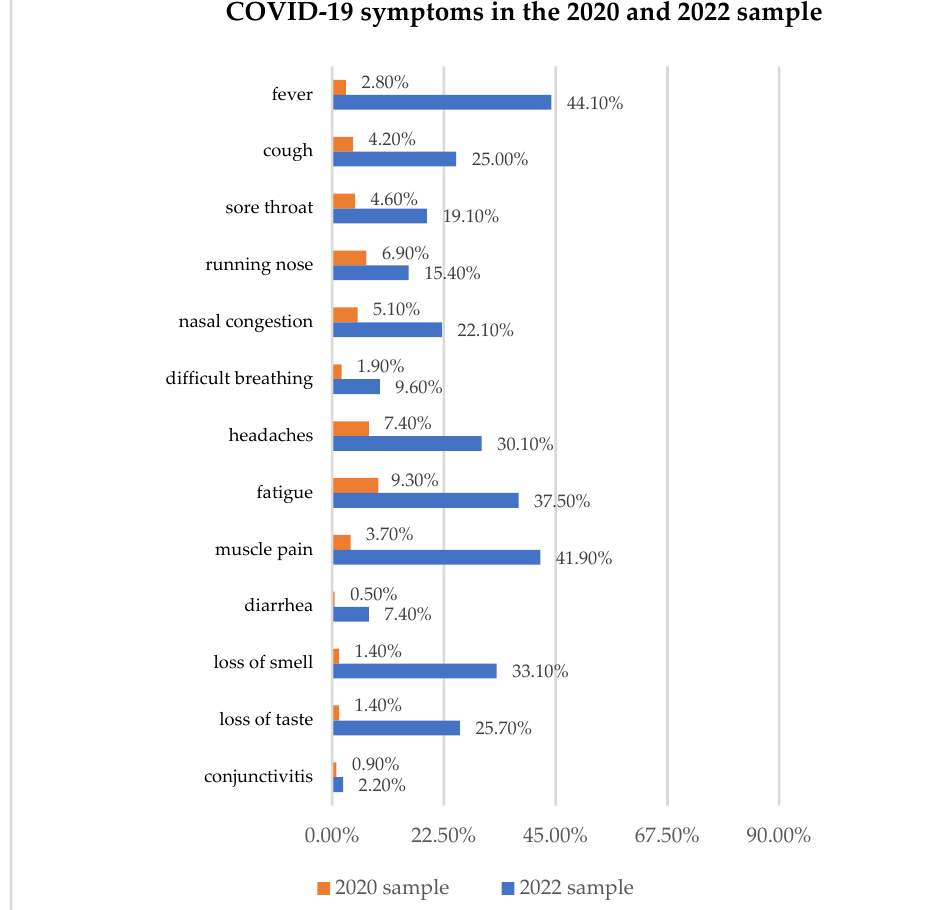
Figure 1. Presence of COVID-19 symptoms in study participants.